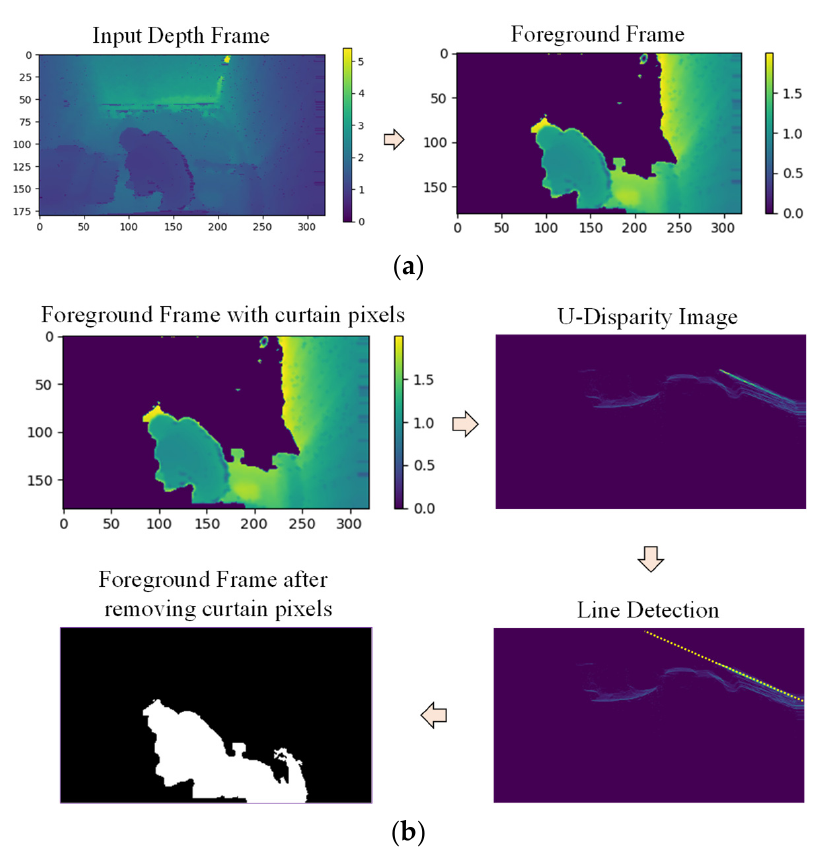
Figure 9. ( a ) Example of foreground frame with curtain; ( b ) Process of curtain removal.